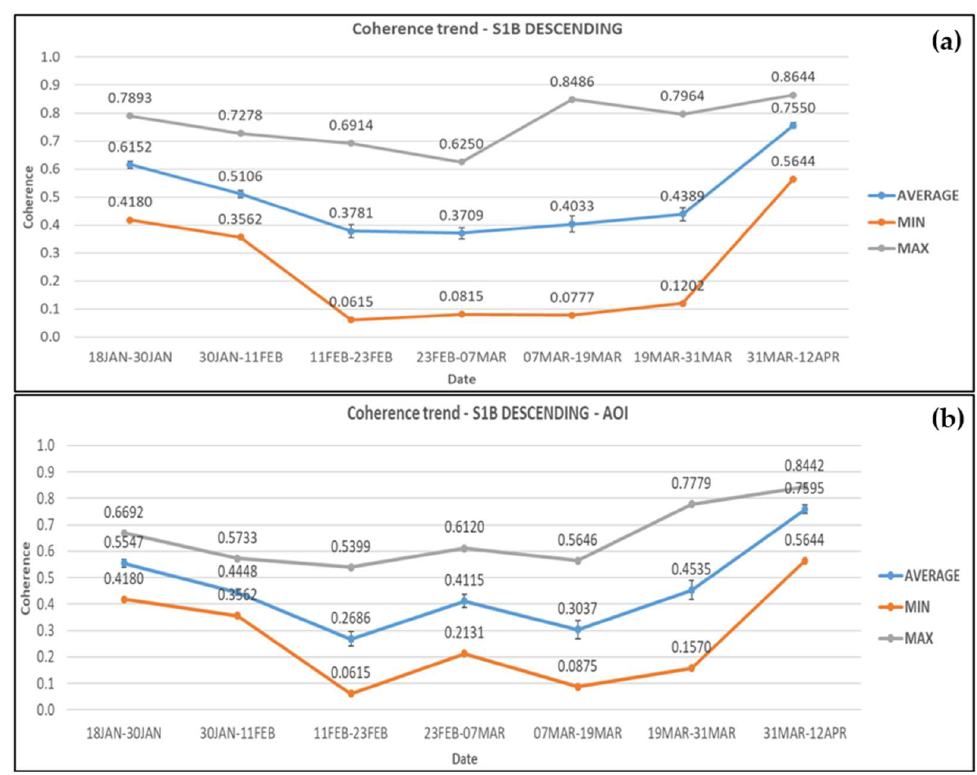
Figure 8. Coherence changes obtained from Sentinel-1B descending satellite images for ( a ) the wider area and ( b ) the AOI. Error bars can be seen in the average coherence